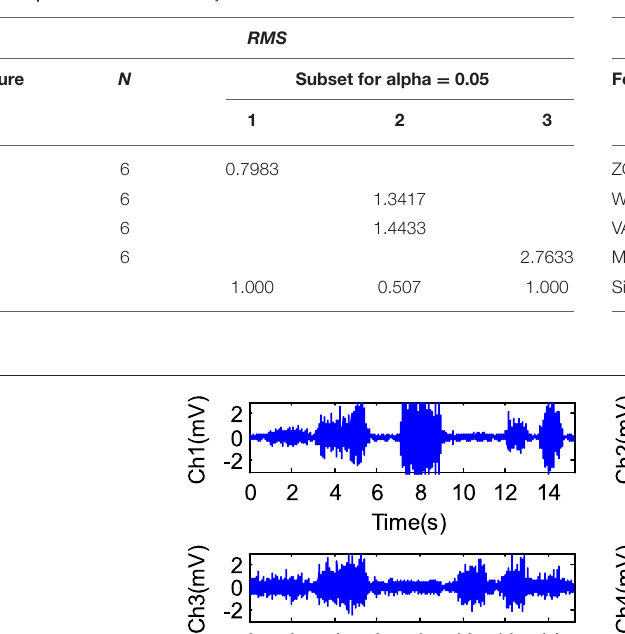
FIGURE 16 | The EMG signals and force signals output by the hand.